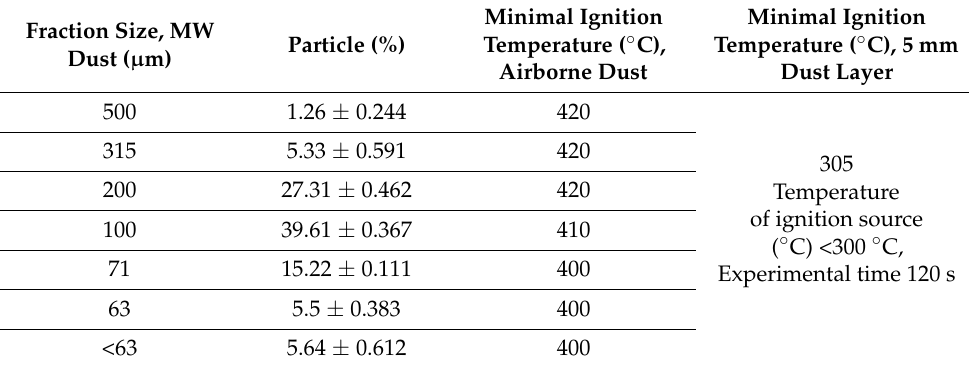
Table 2. Experimental result analysis of marblewood